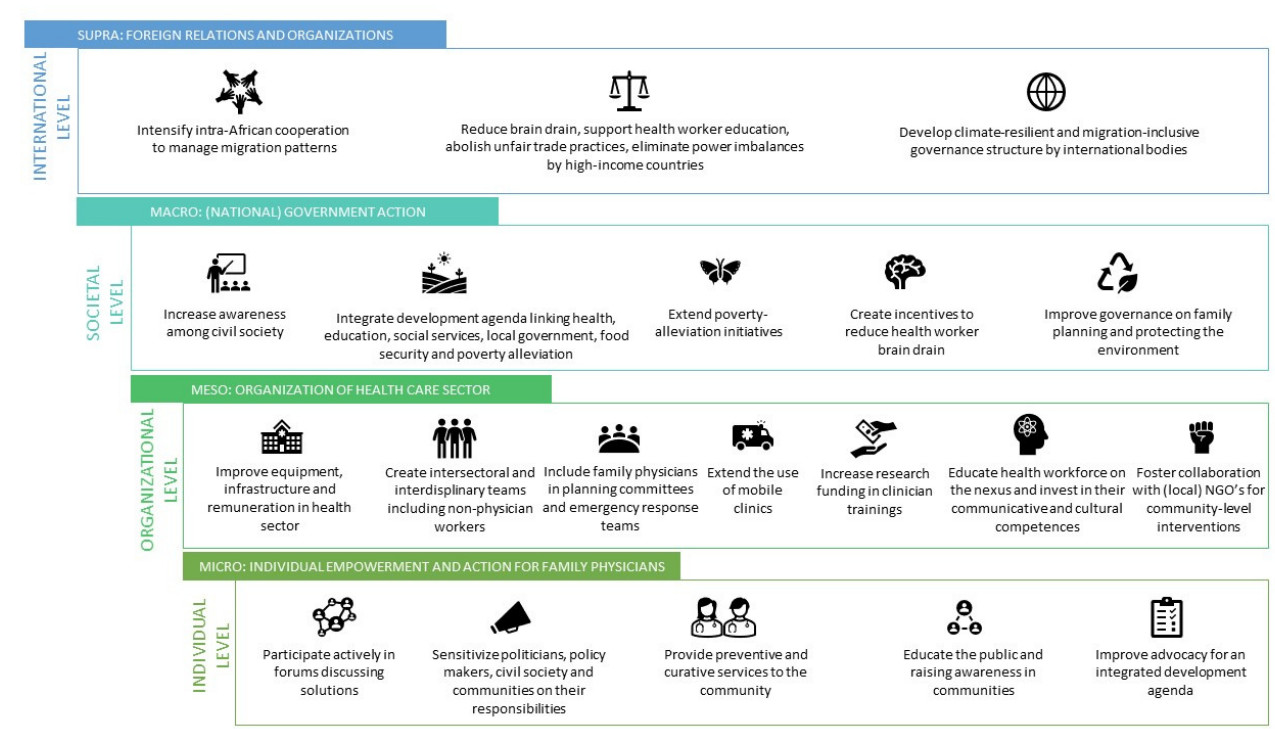
Figure 3. Visualizing intersectoral capacity-building opportunities in the Sub-Saharan African context, on micro, meso, macro, and supra levels.